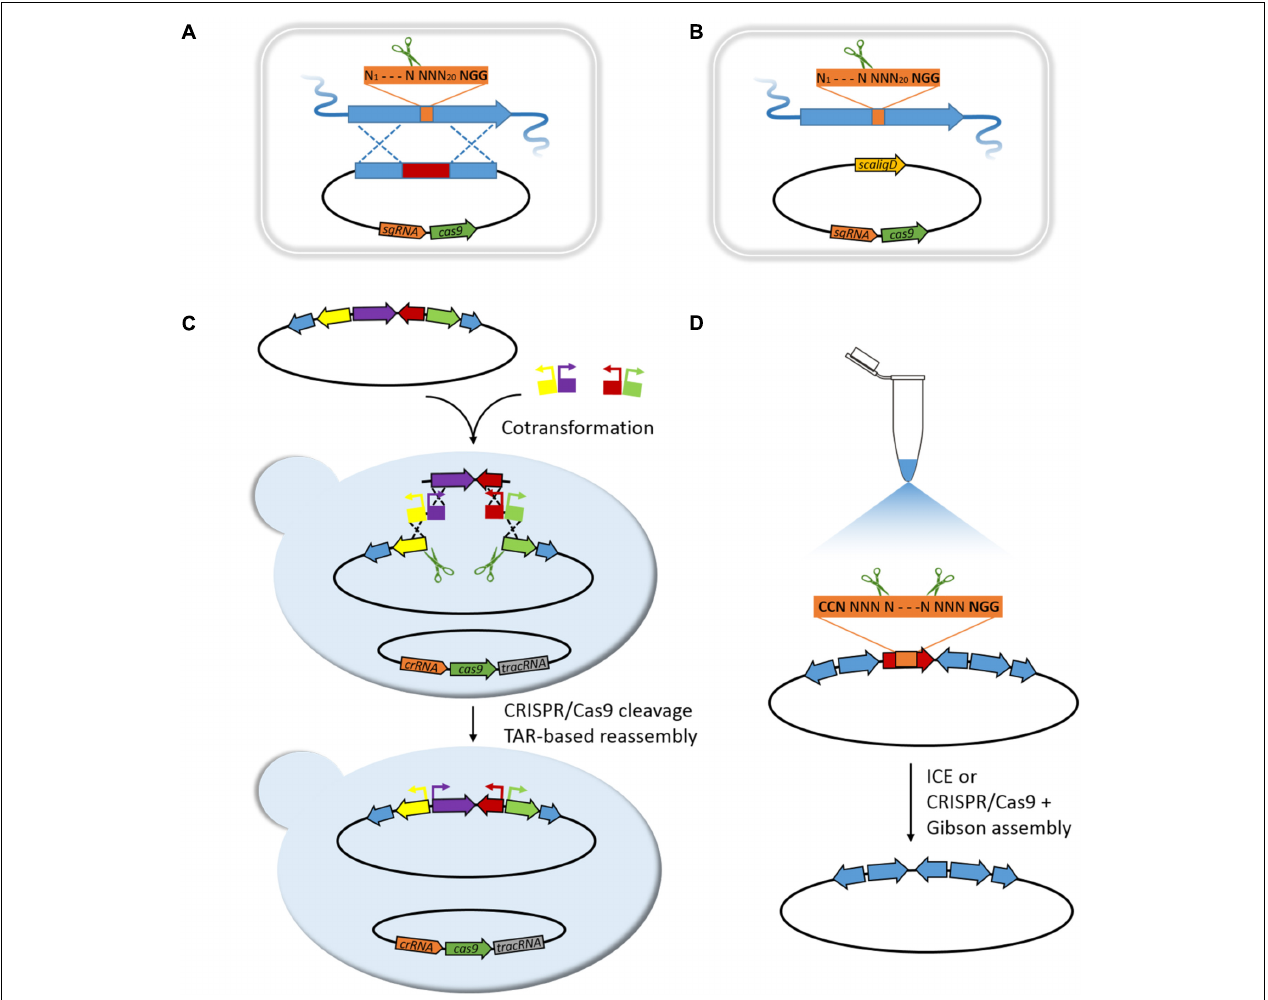
FIGURE 1 | Editing of BGCs based on CRISPR/Cas9 strategies. (A) HDR-mediated editing in Streptomyces . Gene deletion, point mutation, or promoter substitution can be performed, respectively, when the repairing template carries corresponding deletion, point mutation, or promoter replacement. Multiplex loci editing can be achieved by equipping multiplex sgRNA cassettes and corresponding HRTs. (B) NHEJ-mediated editing in Streptomyces . Small sized deletion, insertion, or substitution (mostly 1–3 bp) close to the target site can be achieved by using a reconstituted NHEJ system that co-expressing the scaligD in S. coelicolor . (C) mCRISTAR for BGC refactoring in yeast. (D) In vitro editing of BGC by ICE or SRISPR/Cas9 coupling Gibson